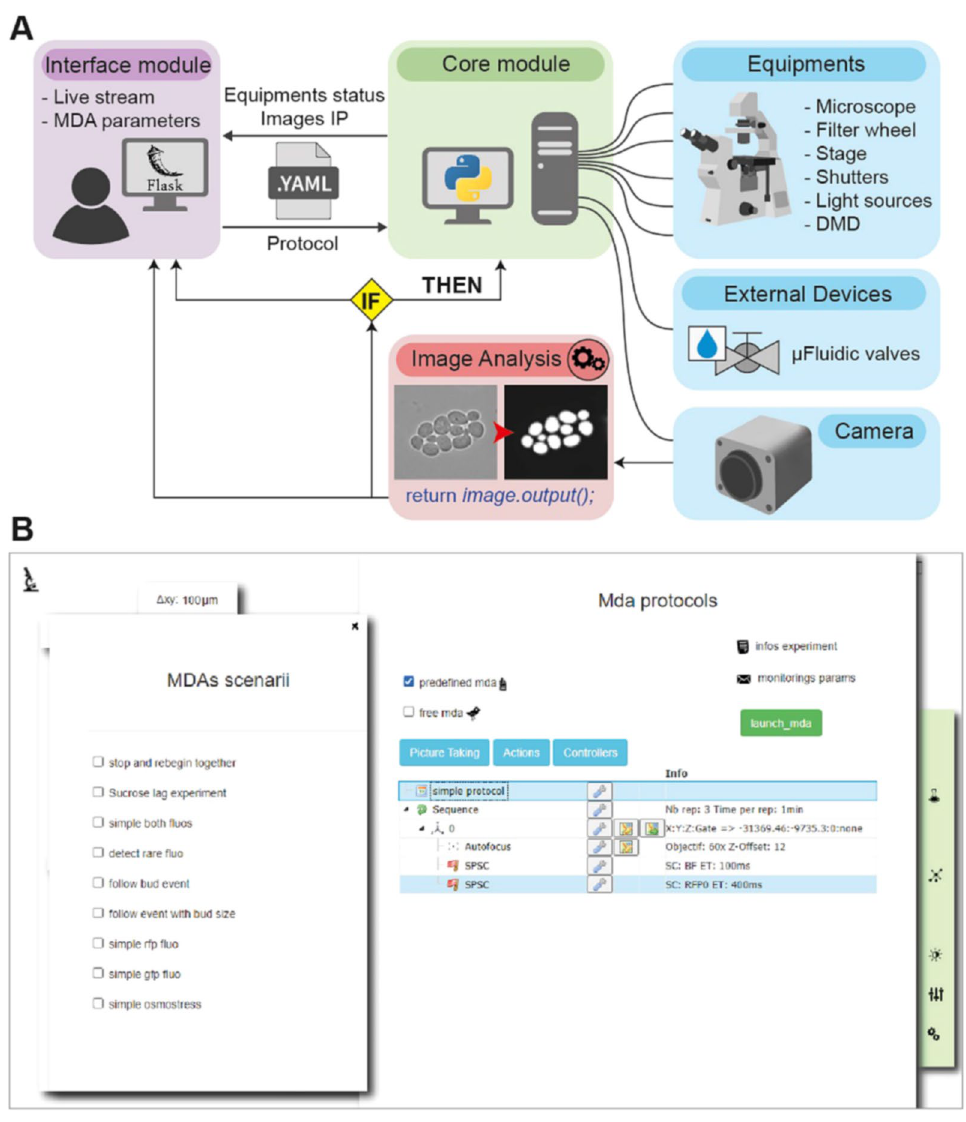
Figure 1. CyberSco.Py framework. ( A ) Architecture. CyberSco.Py is built in Python and uses the web application library Flask to create a web user interface. Microscopy protocols are written into a YAML